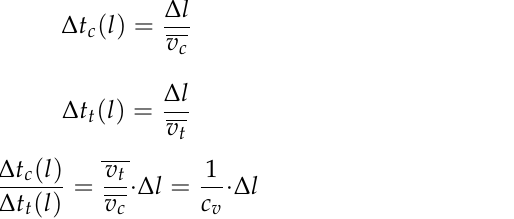
Figure 12. Division of the total volume flow into crossflow 𝑄(cid:4662) (cid:3047) into the tow and longitudinal flow 𝑄(cid:4662) (cid:3030) in the channel.